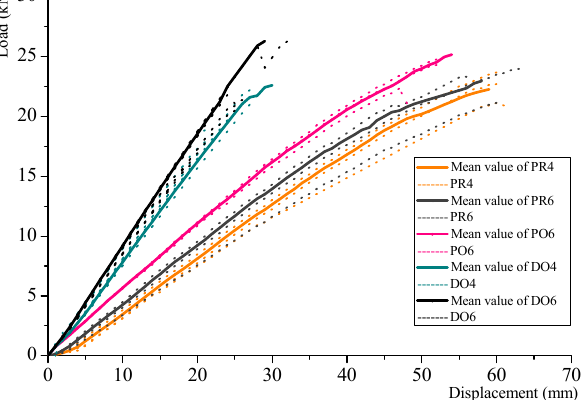
Figure 5. Load displacement curves of mean value of the specimens from each series and single results.